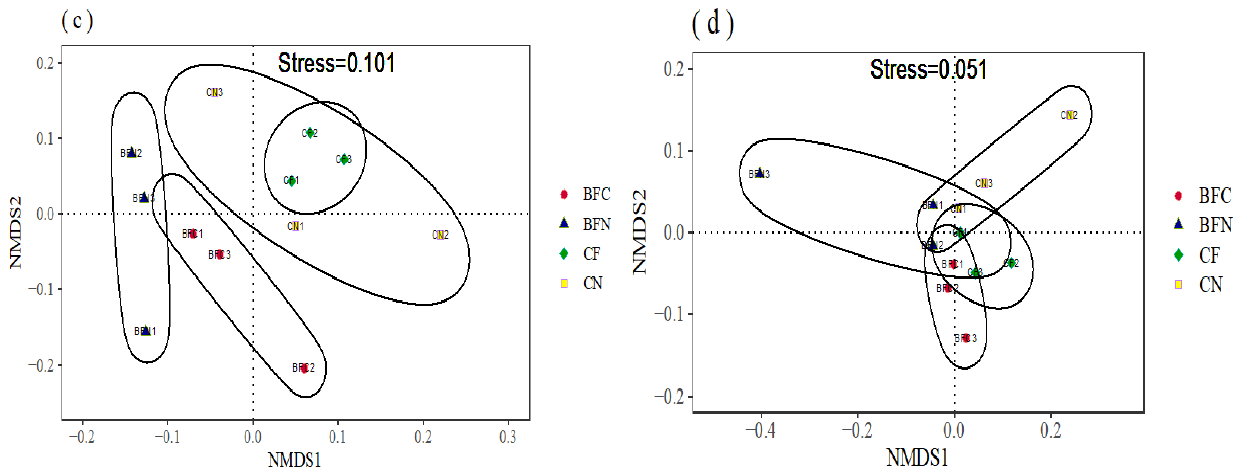
Figure 2. Nonmetric multidimensional scaling (NMDS) of bacteria and fungi community structure at 15 days after transplanting ( a , b ) and fruiting stages ( c , d ) based on Bray–Curtis dissimilarities. Points of different colours or shapes represent samples of different groups.